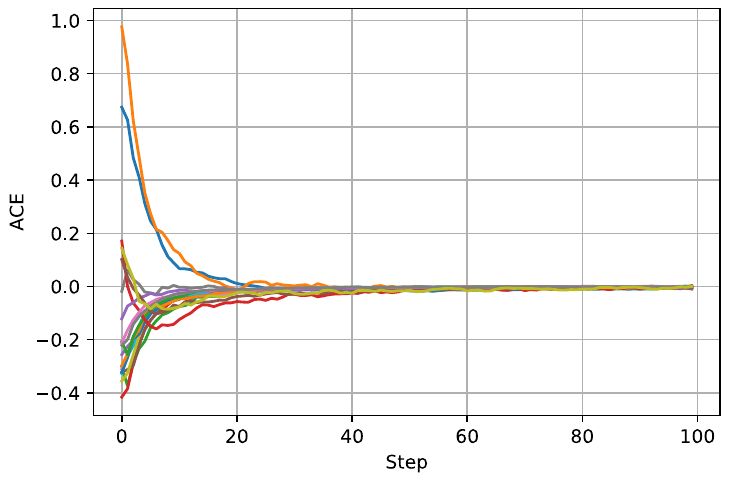
Figure 3. NMSEs of the centralized Kalman filter and local filters. The black dashed line presents the NMSE of centralized Kalman filter, and the solid lines present the NMSEs of 20 local filters.